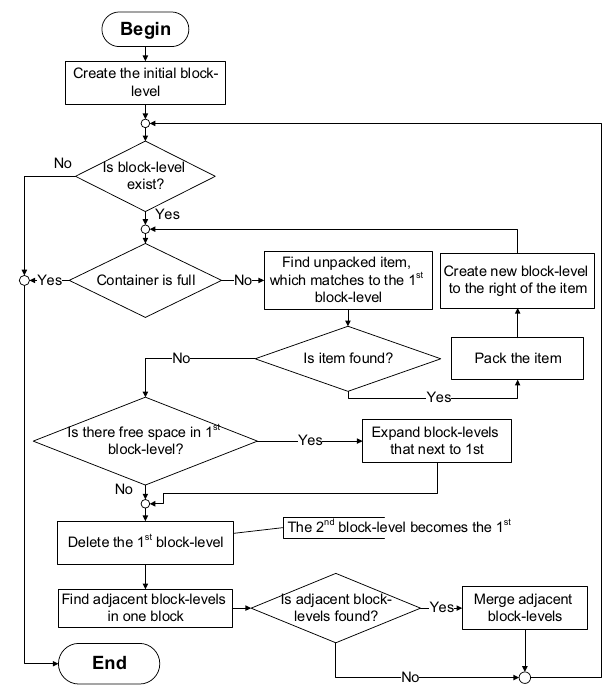
Figure.2. Block diagram of